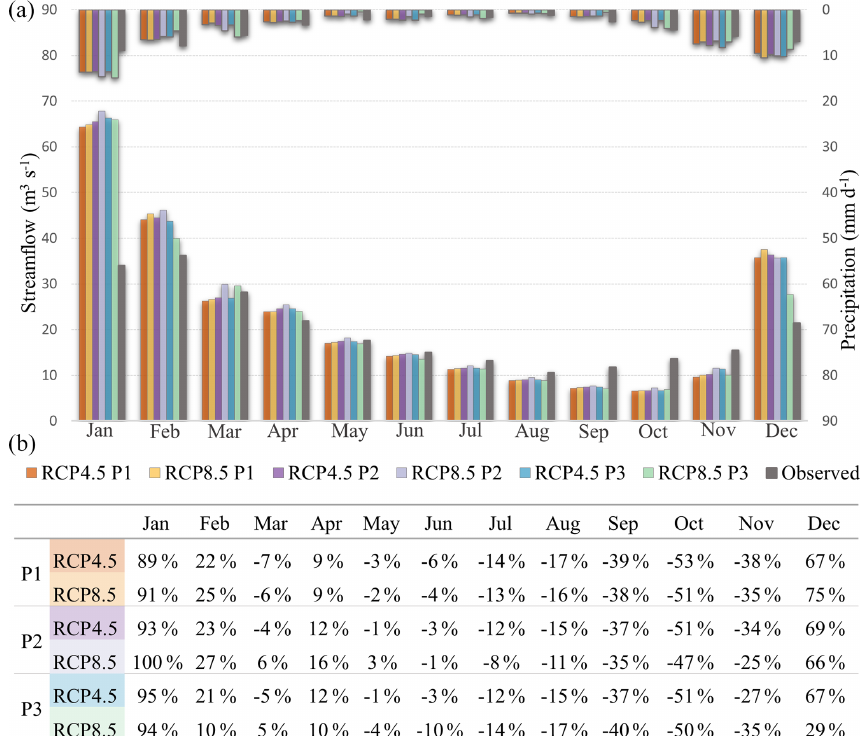
Figure 4. (a) Projected monthly average streamflow and (b) the relative difference between projected and observed streamflow. P1 refers to the immediate future (2010–2040), P2 refers to the intermediate future (2041–2070) and P3 refers to the distant future (2071–2095).